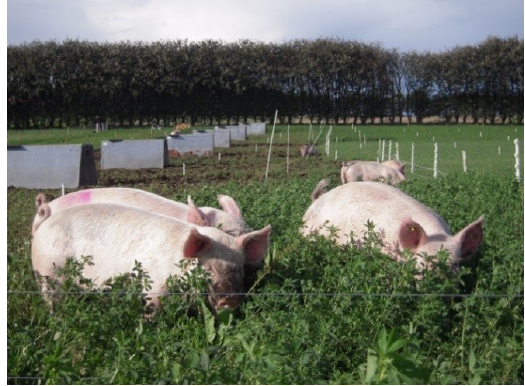
Figure 3. Growing-finishing pigs foraging on grass-clover.